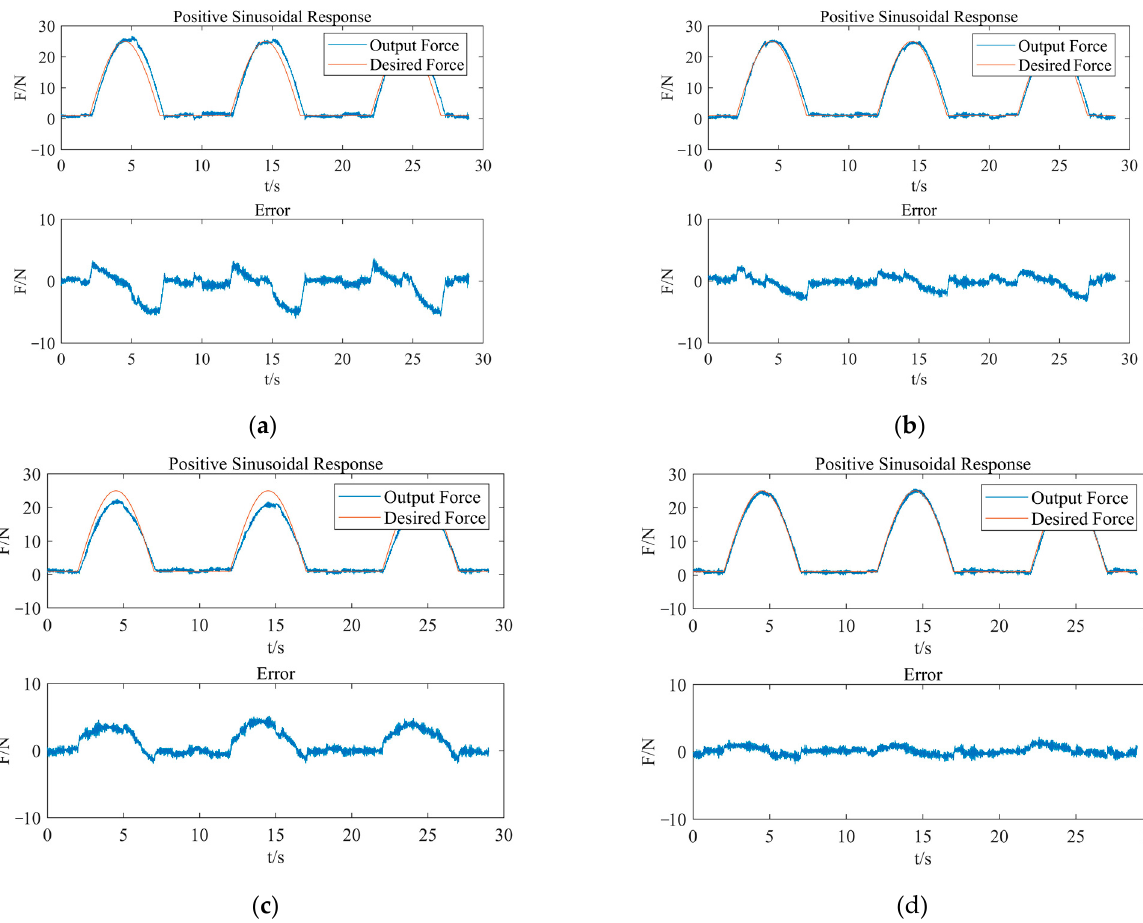
Figure 12. Forward sinusoidal tracking response analysis of contact force. ( a ) Open-loop control; ( b ) PID control; ( c ) fuzzy control; ( d ) fuzzy-RBF-PID control.